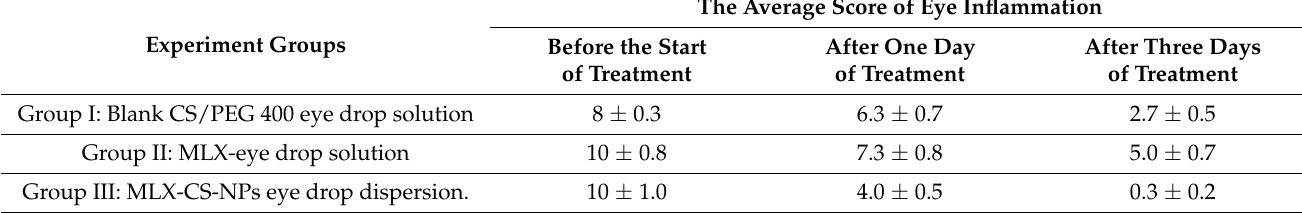
Figure 5. Successive images of representative eyes of rabbits before and after treatment using blank CS/PEG 400 eye drop solution, MLX-eye drop solution, and MLX-CS-NPs eye drop dispersion. Abbreviations: MLX-CS-NPs; MLX/chitosan nanoparticles. Table 9. Clinical examination scoring for the inflamed eyes after applying MLX-CS-NPs eye drop dispersion and MLX-eye drop